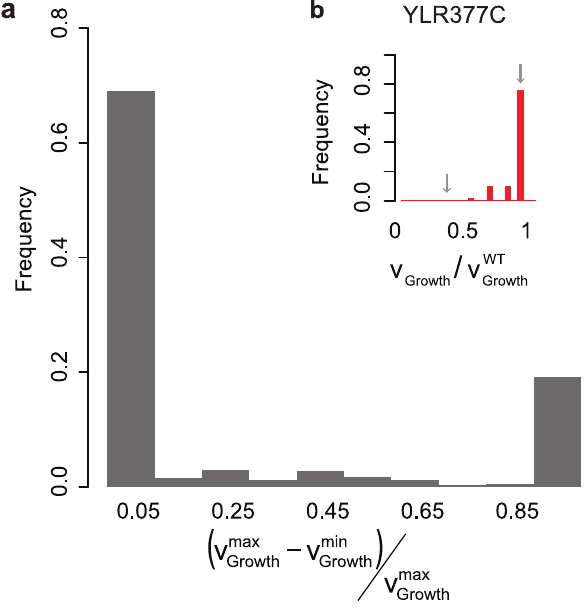
Figure 3. Sensitivity of MiMBl towards the use of alternative reference flux distributions. a ) The histogram shows the distribu- tion of variability in the predicted growth of single gene knockout mutants while using 500 different FBA alternative optima as reference flux distributions. b ) Case study of YLR377C knockout simulations using different reference flux distributions as input. The predicted growth varies between 50–100% of that of the wild-type.